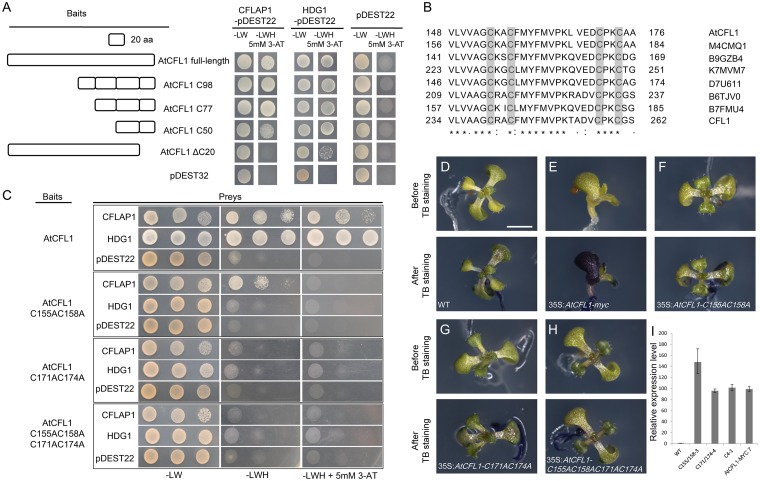
The C-terminal putative zinc finger domain of AtCFL1 is critical for both its interactions with transcription factors and its proper function.(A) The schematic diagram of AtCFL1 and its truncated proteins for yeast two-hybrid assay. From top to bottom, the full length, 98 amino acid residues(C98), 77 amino acid residues(C77) and 50 amino acid residues(C50) of AtCFL1, and C-terminal 20 amino acid residues deleted (ΔC20) respectively. The empty pDEST32 was used as a negative control. The co-transformed yeast strains were plated on the control medium SD-LW and selective medium SD-LWH plus 3-AT. The empty pDEST22 was used as a negative control. (B) Alignment of the C-terminal amino acid residues of AtCFL1, the orthologous proteins from Brassica rapa subsp. Pekinensis (M4CMQ1), Populus trichocarpa (B9GZB4), Glycine max (K7MVM7), Vitis vinifera (D7U611), Zea mays (B6TJV0), Humulus japonicas (B7FMU4) and rice (CFL1). Asterisks indicate identical residues, colons indicate highly similar residues and dots indicate slightly similar residues, shades indicate the four cysteine residues of the putative C4 zinc finger. (C) The results of yeast two-hybrid assay for the interactions of CFLAP1 and HDG1 with mutated AtCFL1s. The baits were wild-type AtCFL1, AtCFL1 with C155 and C158 residues mutated, AtCFL1 with C171 and C174 residues mutated and AtCFL1 with C155, C158, C171 and C174 residues mutated respectively. The co-transformed yeast strains were plated on the control medium SD-LW and selective medium SD-LWH plus 3-AT. The empty pDEST22 was used as a negative control. (D) to (H) TB staining assay of 14-day-old seedlings. (D), wild type; (E), 35S:AtCFL1-myc; (F), 35S:AtCFL1-C155AC158A; (G), 35S:ATCFL1-C171AC174A; (H) 35S:ATCFL1-C155AC158A C171AC174A. Top, before TB staining; bottom, after TB staining. Bar = 1 mm. (I) The relative expression levels of AtCFL1 in the seedlings of (D) to (H). The expression level in wild types is set to 1.0. The error bars represent the SD of three biological replicates.